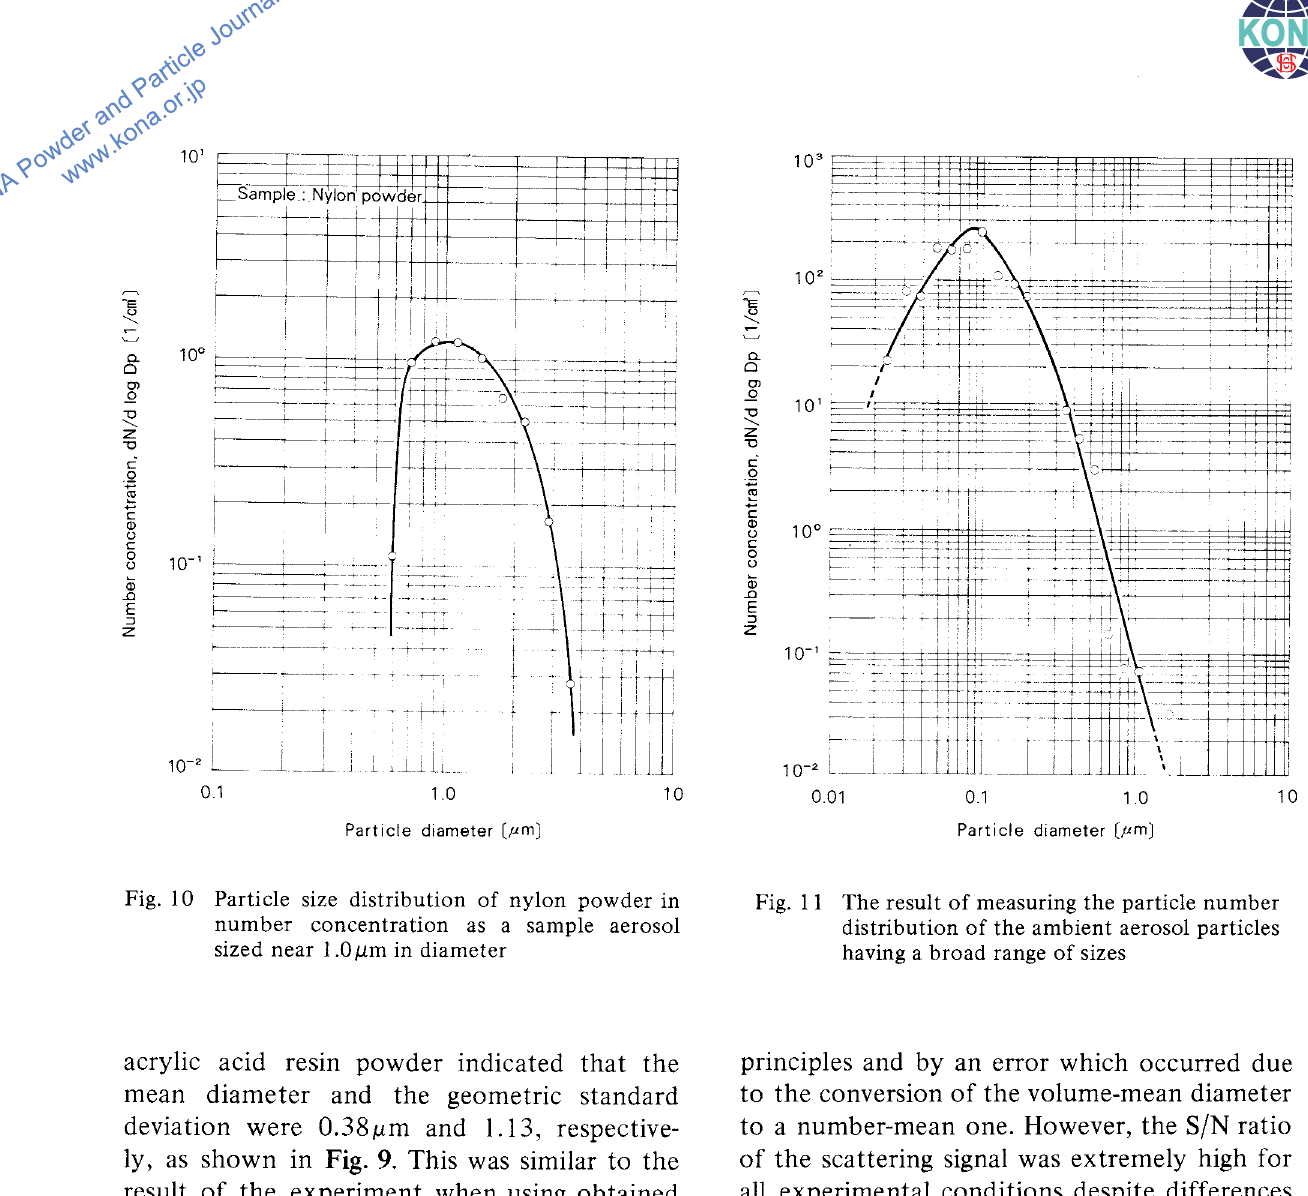
Fig. II The result of measuring the particle number distribution of the ambient aerosol particles having a broad range of sizes